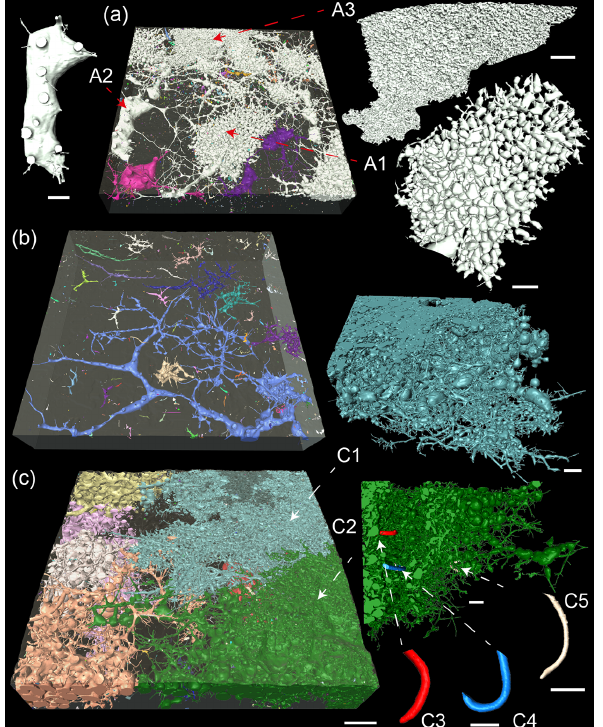
Figure 5. Micro-computed tomographic visualisation of bioerosion traces in experimental blocks deployed for 8–14 years. (a) 8-year block with Entobia cf. ovula (A1), E. magna (A2), and E . cf. parva (A3); (b) 8–9-year block with E. megastoma ; and (c) 14-year block with E . cf. cretacea (C1–C2) and Trypanites isp. (C3–C5) (scales A1–A3, C1–C2 = 5mm; scales C3–C5 = 1mm; size of blocks is 90 × 90 × 18mm).